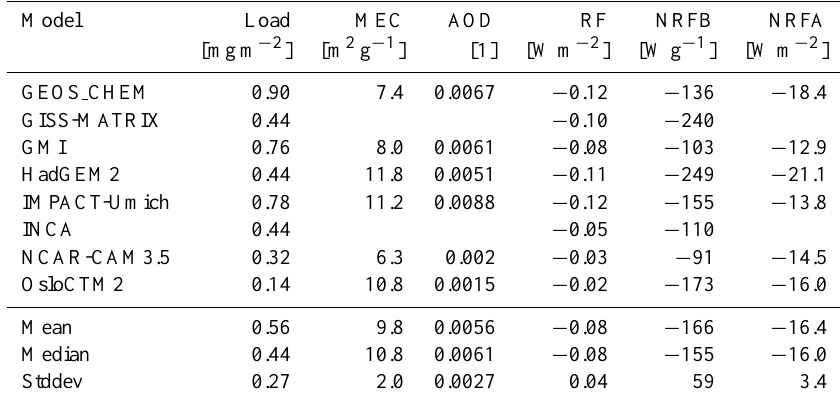
Fig. 11. Zonal mean SOA RF (a) , burden (b) , AOD at 550nm (c) , NRF(A) (d) . Table 8. Same as Table 4 for